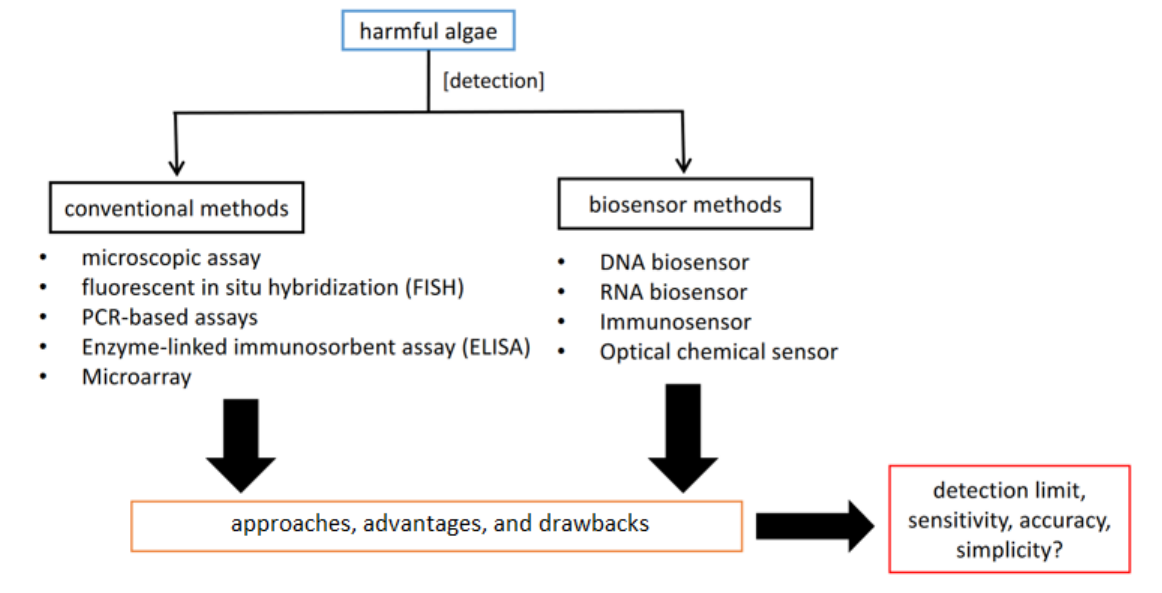
Figure 1. General overview of the review paper.